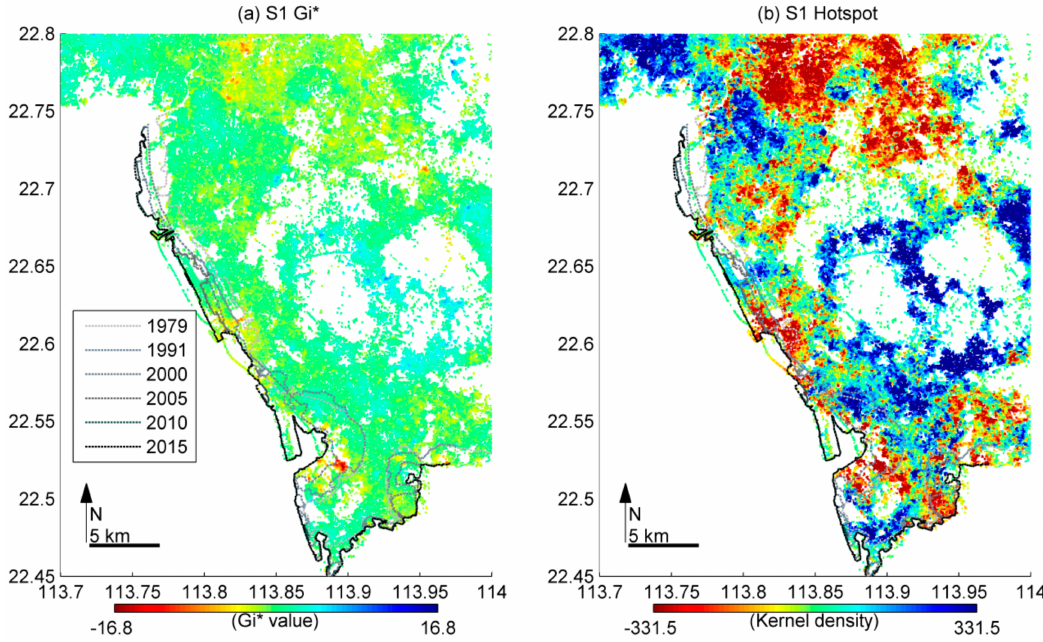
Figure A4. The clustering of mean rates using Getis–Ord Gi* statistic for S1. ( a ) Gi* values; ( b ) Hotspot map derived from a kernel density